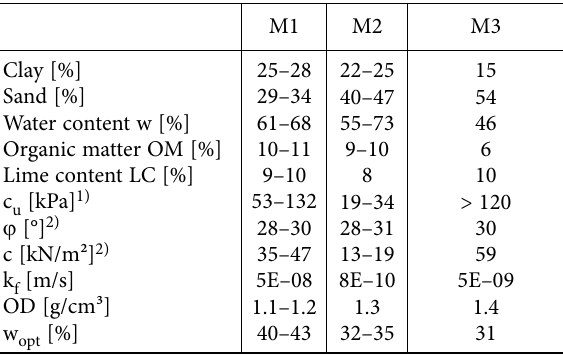
Table 1. Selected geotechnical properties